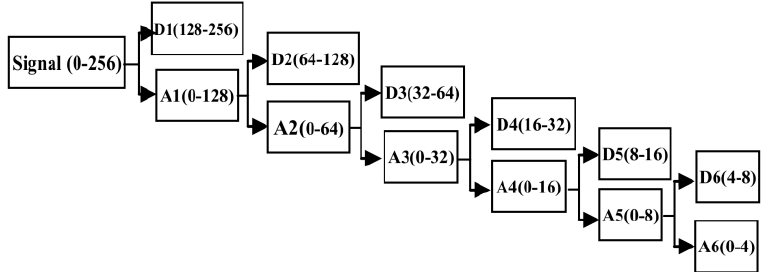
Figure 7. Decomposition space tree.